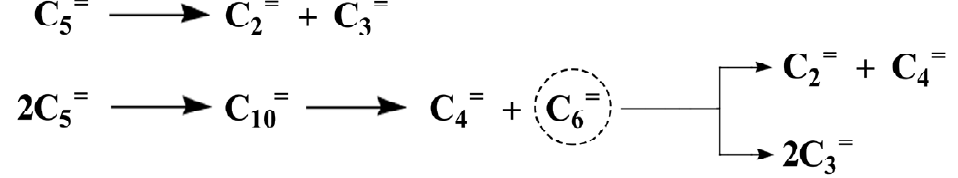
Figure 1. Reaction routes of pentene mono- and bimolecular cracking.